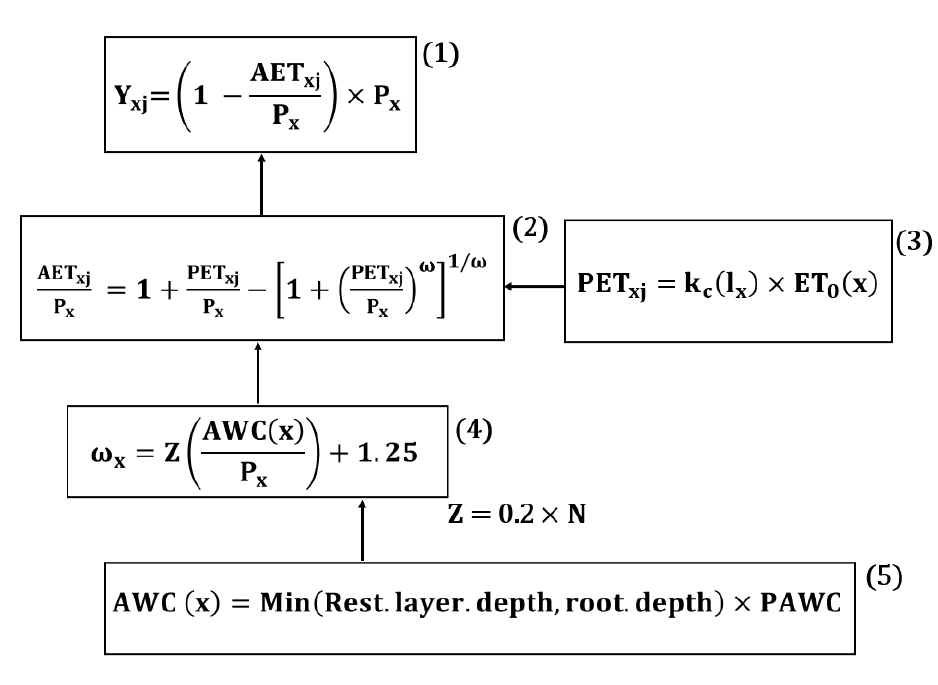
Figure 2. Model’s physical expressions.